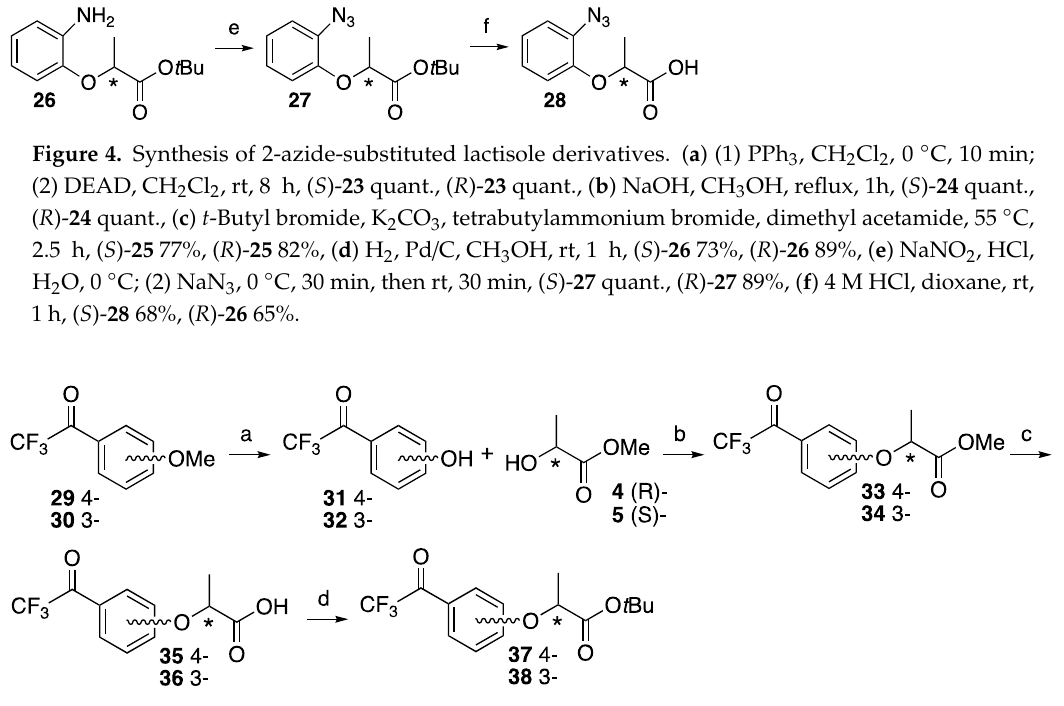
Figure 6. Synthesis of 2-trifluoroacetyl lactisole derivative. ( a ) 1,3-propanedithiol, I 2 , CH 2 Cl 2 , rt, 1 h, 95%, ( b ) (1) 4 or 5 , PPh 3 , CH 2 Cl 2 , 0 °C, 10 min; (2) DEAD, CH 2 Cl 2 , rt, 8 h, ( S )- 41 98%, ( R )- 41 98%, ( c ) K 2 CO 3 , MeOH, H 2 O, reflux, 1 h, ( S )- 42 quant., ( R )- 42 quant, ( d ) t -BuBr, K 2 CO 3 , TBAB, DMA, 55 °C, 2.5 h, ( S )- 43 83%, ( R )- 43 82%, ( e ) CH 3 I, NaHCO 3 , CH 3 CN, H 2 O, rt, 24 h, ( S )- 44 78%, ( R )- 44 79%, ( f ) (1) TMS-CF 3 , K 2 CO 3 , DMF, rt, 4 h, (2) 1 M HCl, rt, 4 h; (3) Dess–Martin periodinane, CH 2 Cl 2 , rt, 3 h, ( S )- 45 85%, ( R )- 45 89%. Each trifluoroacetyl-substituted lactisole tert -butyl esters ( 37 , 38 , 45 ) was subjected to diazirine constructions, oximation with hydroxylamine hydrochloride 46 – 48 , tosylation for hydroxyl group of oxime 49 – 51 , diaziridine formation with liquid ammonia 52 – 54 , and oxidation with activated MnO 2 to obtain 55 – 57 , which were checked by chiral center configuration. tert -Butyl esters were hydrolyzed with trifluoroacetic acid to afford trifluoromethyldiazirine-based lactisole derivatives in moderate yields. The one-pot conversion of the tosyl oxime 49 to diazirine 55 [36] was also acceptable for the preparation with an identical yield (Figure 7).